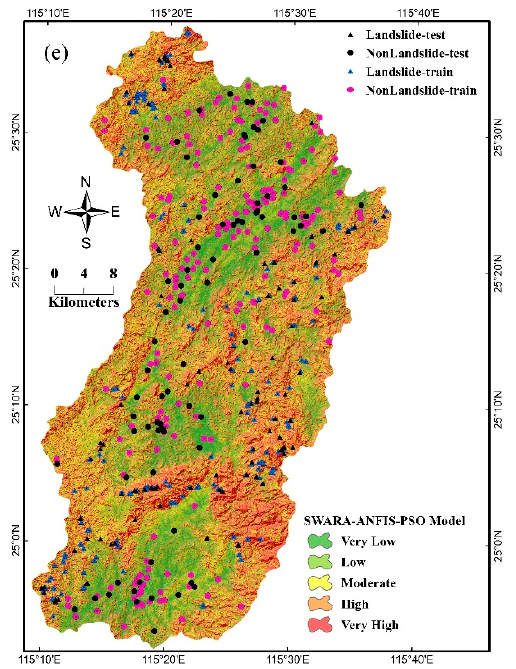
Figure 14. Landslide susceptibility maps. ( a ) SWARA-ANFIS-WOA, ( b ) SWARA-ANFIS-GWO, ( c ) SWARA, ( d ) SWARA-ANFIS, ( e ) SWARA-ANFIS-PSO.